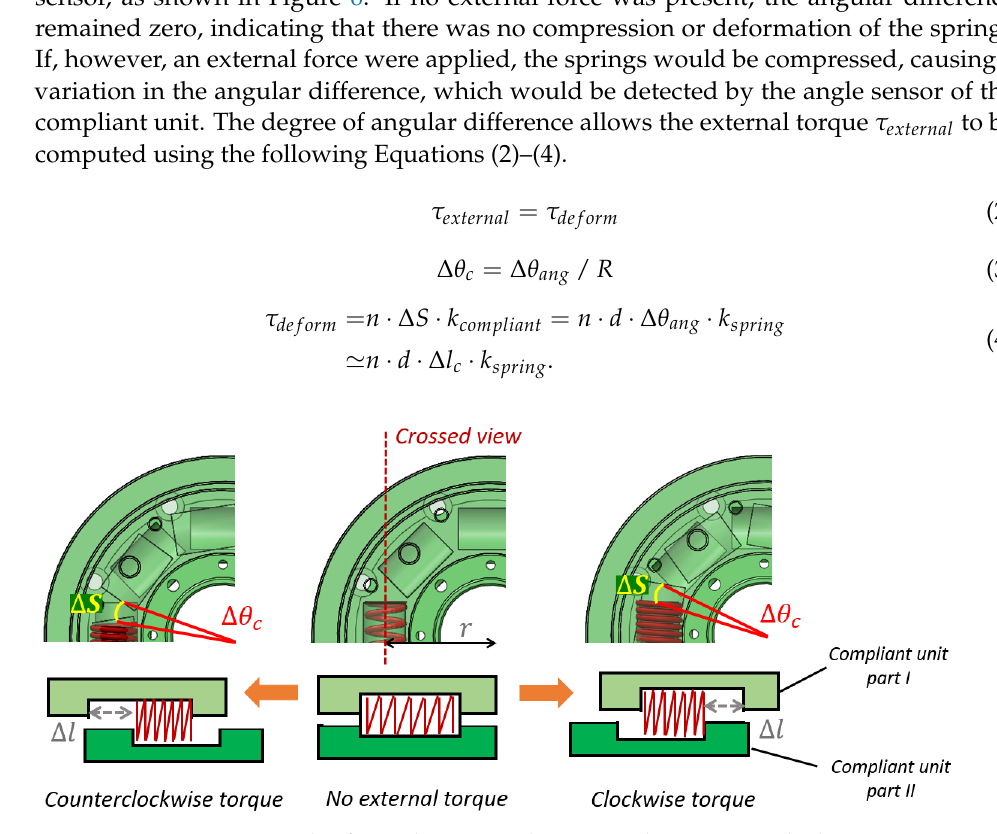
Figure 6. Operating principle of compliant unit when external torque is applied. Here, τ deform is the torque after the spring has been compressed; θ c is the angular difference between compliant unit parts one and two, and θ angle is the angle measured from the angular position sensor. Additionally, R is the ratio of the two gears (1:4) and the ratio between ∆ θ c and ∆ θ ang . The quantity d is the radius (29.5 mm) from the center to the spring, and k compliant and k spring are the stiffness of the compliant unit and the elasticity coefficient of the spring, respectively. Furthermore, n is the number of springs placed in the compliant unit (four in the current study). ∆ S and ∆ l c are the variations in arc length and linear distance when the springs are deformed. The design of the compliant unit allows the maximum deformation of the spring when ∆ θ ang equals 10 ◦ . Therefore, the measurable torque ranges from 0 to 42